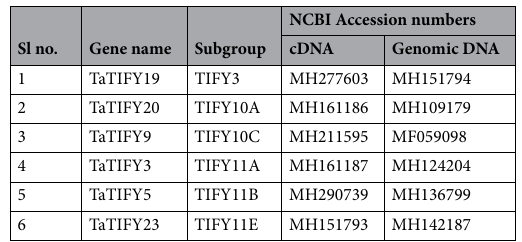
Table 2. Accession numbers of cDNA and genomic DNA of TIFY sequences submitted at NCBI.